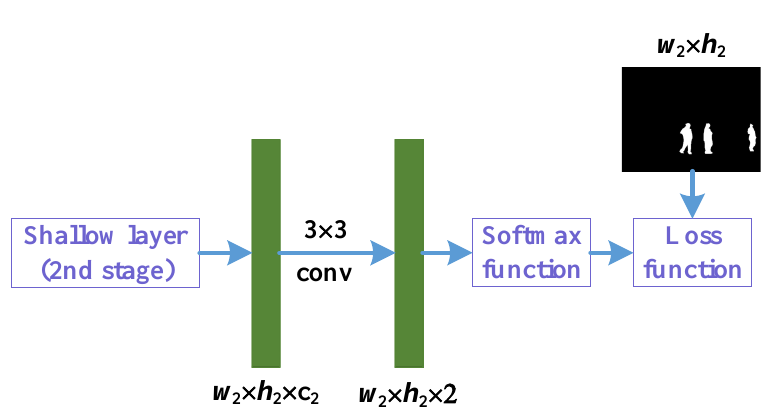
Figure 4. The focused feature enhancement for the second